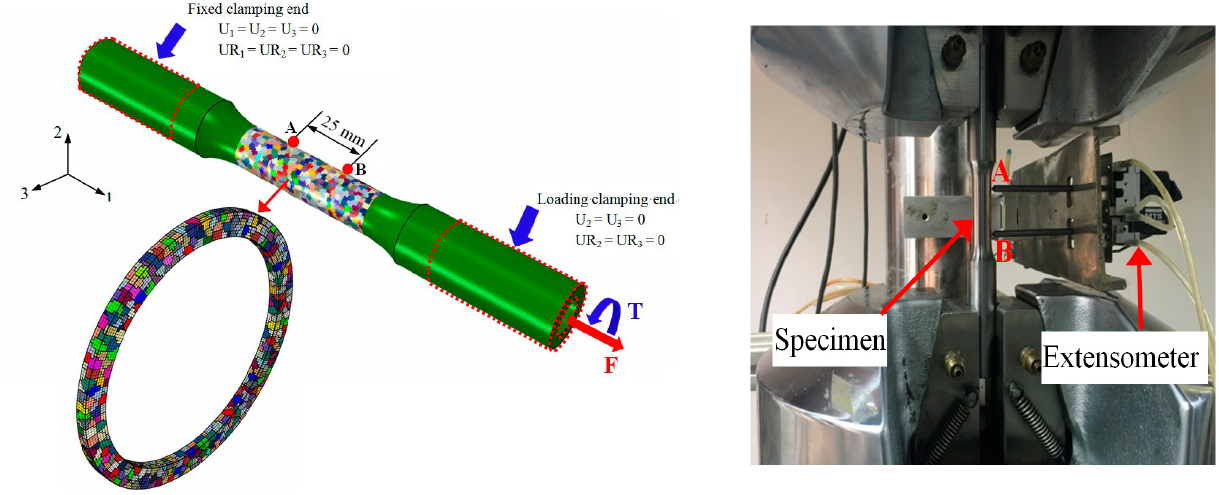
Figure 6. The loading process of the global finite element model (GFEM) containing 3600 grains under the combined tension–torsion loading.